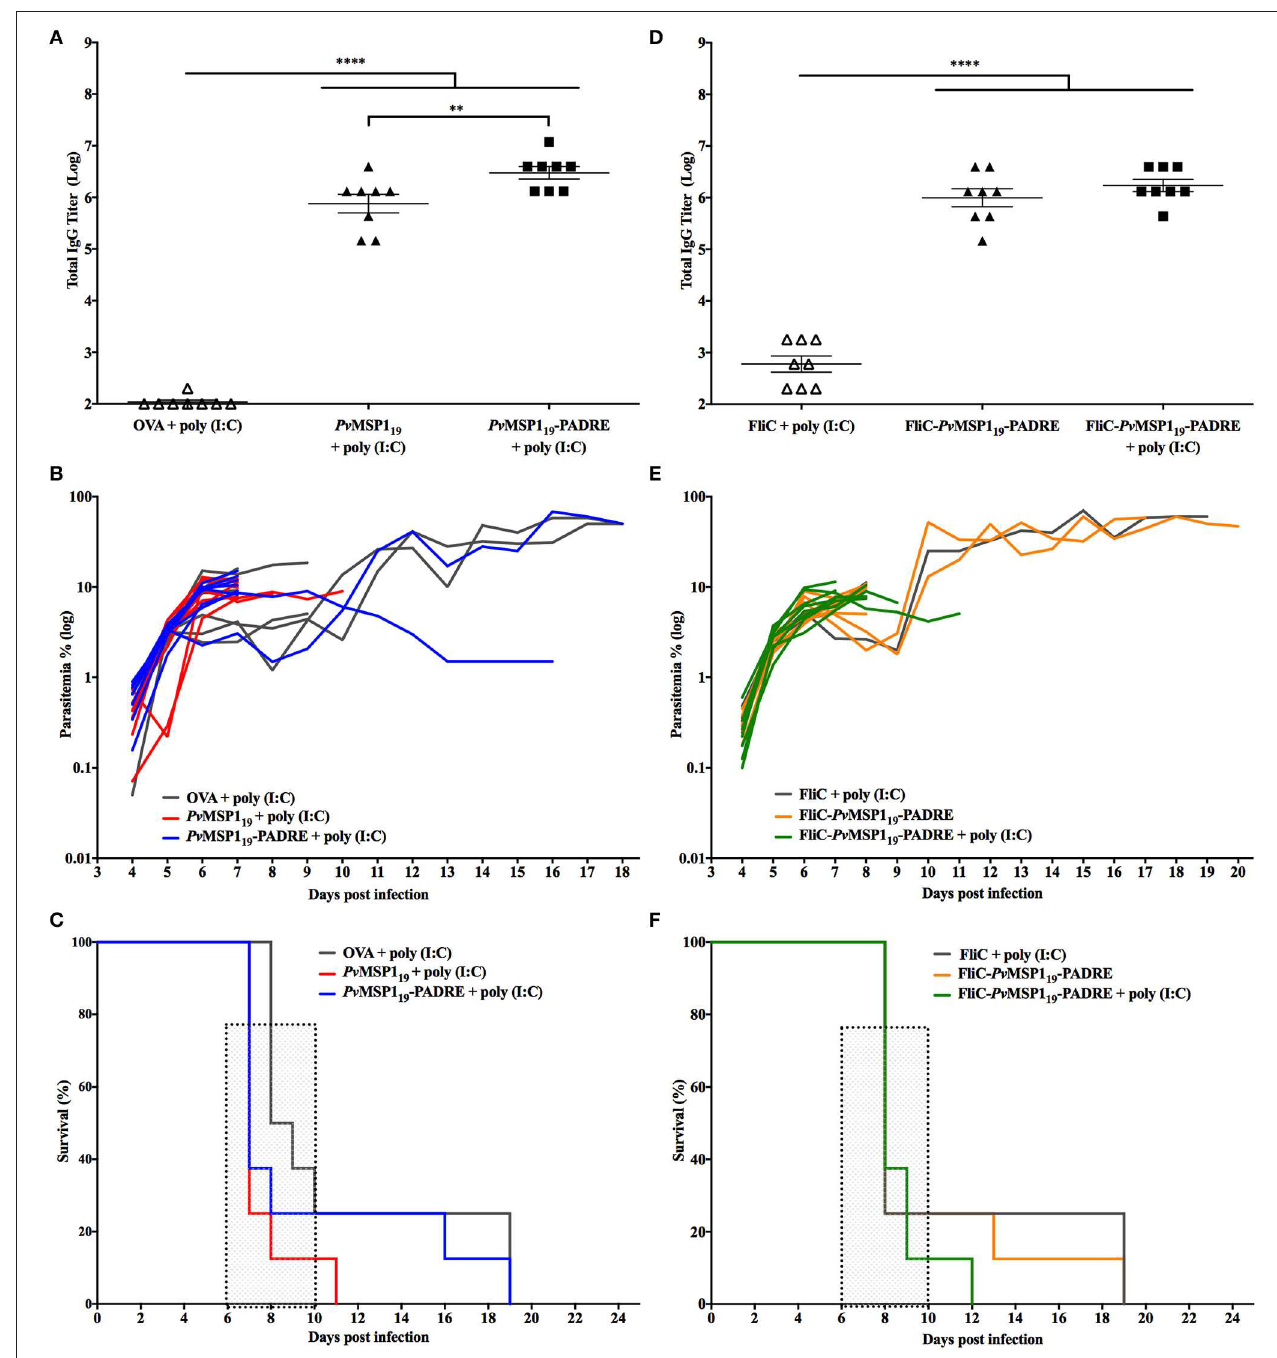
FIGURE 4 | Immunizations with Pv MSP1 19 -based formulations do not protect C57BL/6 mice from challenge with Pb/Pv MSP1 ANKA 19 . C57BL/6 mice ( n = 8) were vaccinated with three immunizing doses of HIS 6 - Pv MSP1 19 + poly (I:C), HIS 6 - Pv MSP1 19 -PADRE + poly (I:C), HIS 6 -FliC- Pv MSP1 19 -PADRE, HIS 6 -FliC- Pv MSP1 19 -PADRE + poly (I:C), or with the control formulations Ovalbumin (OVA) + poly (I:C) or Flagellin (FliC) + poly (I:C). HIS 6 - is omitted from the name of the recombinant proteins in the figure. (A,D) Total IgG titers (Log) after the third immunizing dose. Each symbol represents one animal of the indicated groups. (B,E) Mice were challenged i.v. with 5 × 10 3 red blood cells infected with the hybrid line Pb/Pv MSP1 ANKA 19 and the parasitemia was followed daily by blood smears. Each line represents one mouse of the indicated groups. (C,F) Mortality curves of the indicated groups. Dashed boxes show the window of time when typic cerebral complications occur. One-way ANOVA followed by Tukey’s HSD test: ** p < 0.01 and **** p < 0.0001.